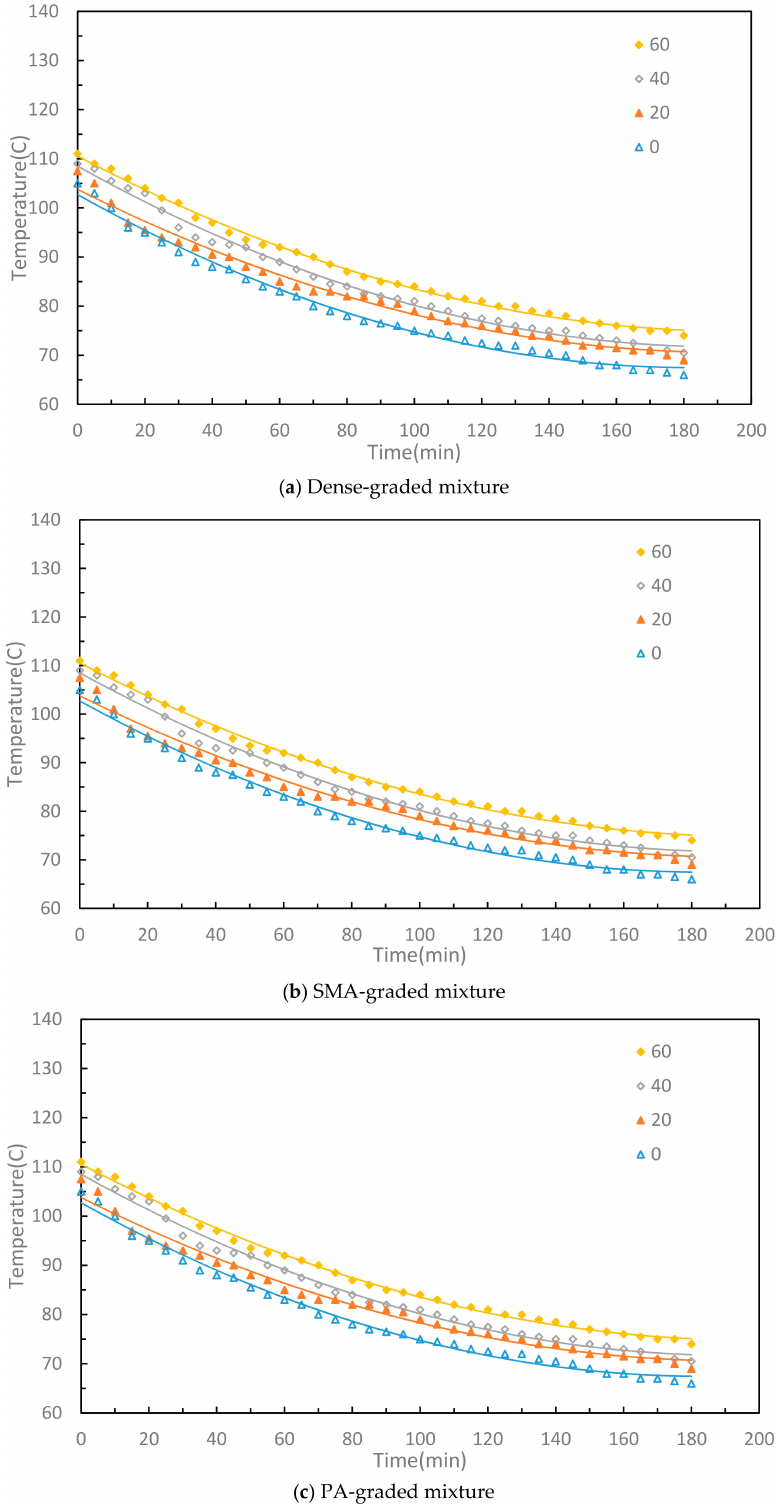
Figure 3. Temperature gradient variation